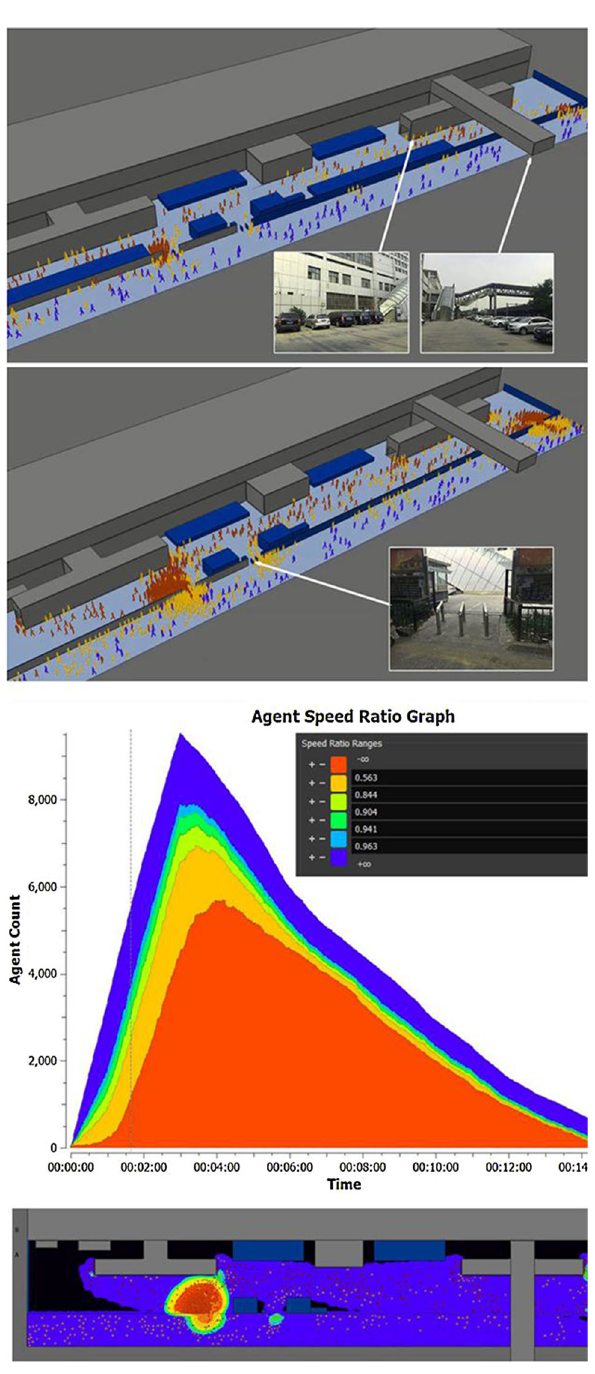
b Fig. 5 Top Data collection from ticketing system. Middle Peak hours crowd simulation. 100 people/min. Middle The number of the agent with low moving speed is represented as a red color graph . The value increases due to the congestion in the certain area. The value eventually drops down once the congestion is dissolved. By studying the curve graph over the time line, designers and planners can understand the length and scale of a congestion and its impact on the crowd movement. Bottom Peak hours crowd simulation. 300 people/ min. ABS shows that congestion areas of A/B exit square are mainly in three places located on the exit of the fence. Simulation results show that most blue and black area can be used for parking, business, leisure, and other functions. These areas can be used to accommodate more diverse urban functions. The agent speed analysis is used to compare the performance of